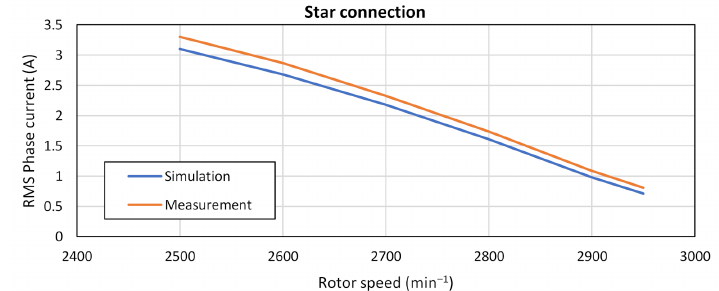
Figure 27. Dependence of phase a motor current on speed for the fault-free state in the star connection. In the fault-free state, all currents are the same (symmetrical), with a phase shift of 72 ◦ . However, this does not apply if there is a phase failure. In this state, the amplitudes and phase shifts of the individual currents